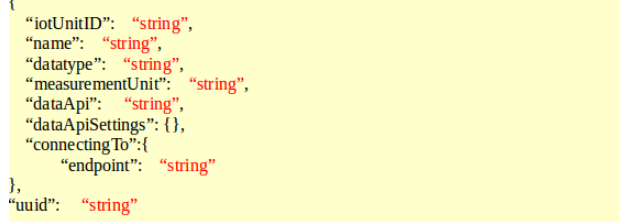
Figure 5. rsiHub Global API the list of data